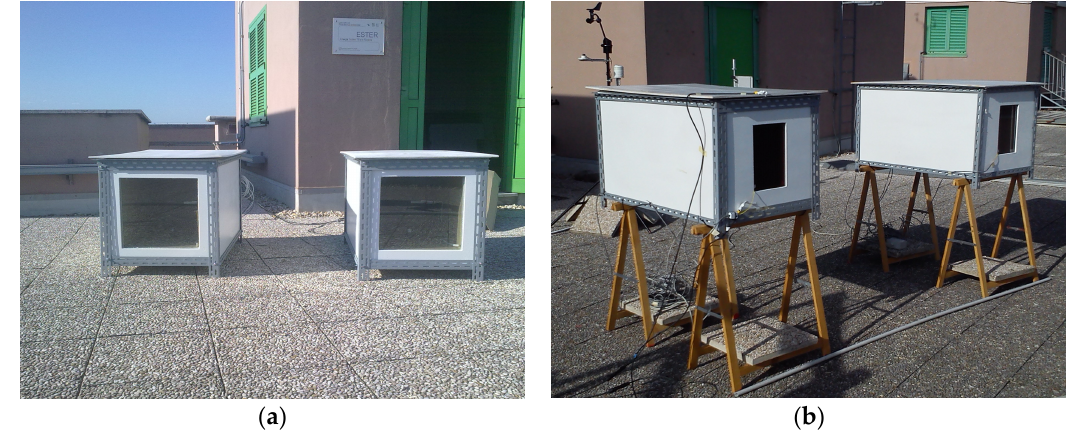
Figure 2. Solar Test Boxes at ESTER lab: ( a ) Solar test boxes (STBs) in the original configuration with a glazed surface; ( b ) STB used for the present study with a wider frame applied.